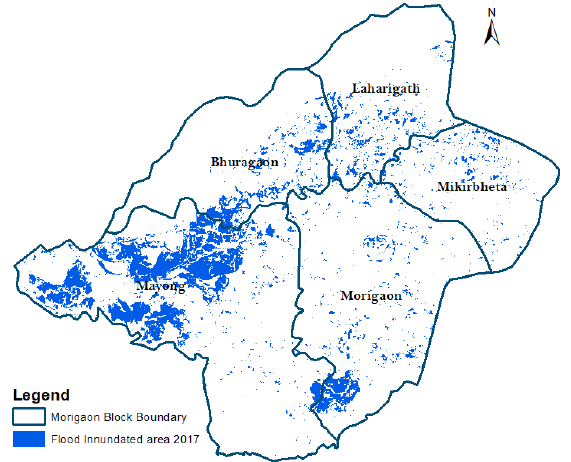
Figure 5. Total Flood inundated area of Morigaon District